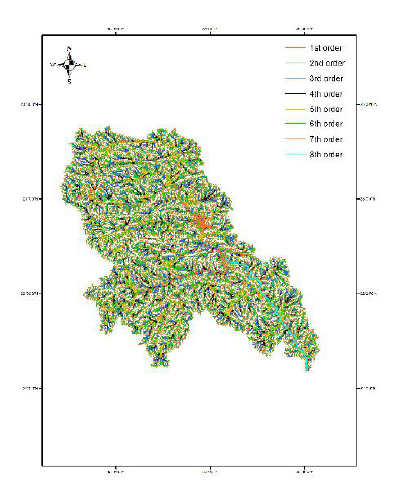
Figure 3: river network and stream order of upper watershed of River Subarnarekha